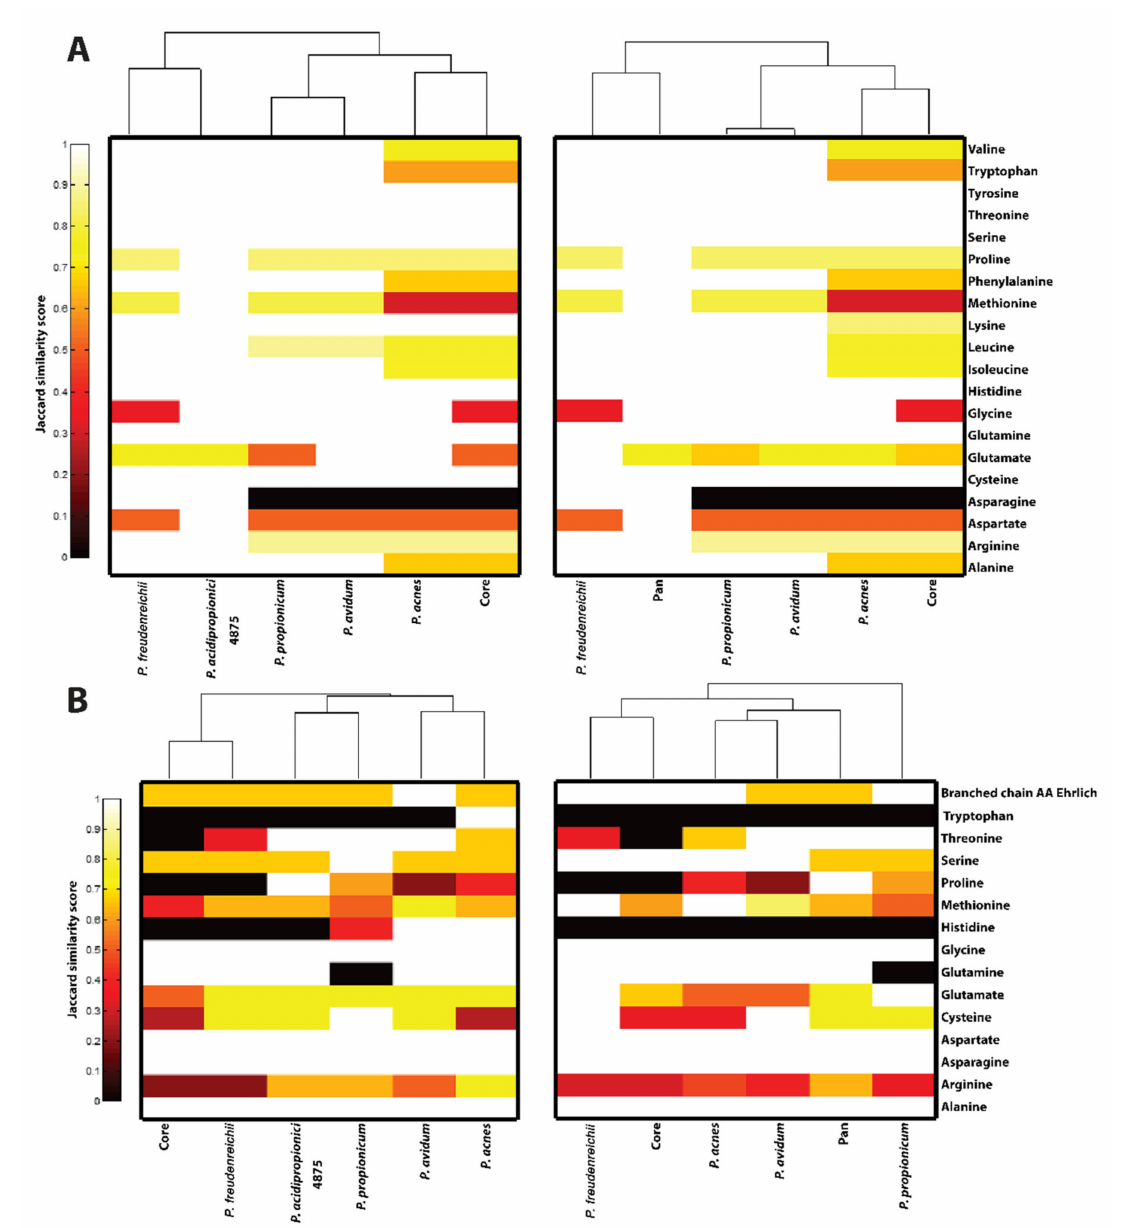
Figure 6. Heat map and clustering of amino acid biosynthesis ( A ) and degradation ( B ) pathways using the Jaccard similarity metric. In this metric, 0 represents no reactions in common, and 1 represents all reactions shared. Plots to the left are referenced to the pan-reactome (distances represent the proportion of all reactions of the pan-genome ascribed to that pathway present in the organism), while plots to the right represent the same information referenced to P. acidipropionici 4875. Commensal strains are observed to have a reduced set of biosynthetic capabilities for amino acids and cluster out from the dairy strains. Extensive variability is observed in the arginine, methionine, and proline degradation pathways. The reductive arginine degradation pathway is observed in P. acidipropionici , while the oxidative pathway is observed in commensal species, possibly reflecting adaptation to aerobic conditions. Histidine and tryptophan degradation capabilities are observed only in selected commensal